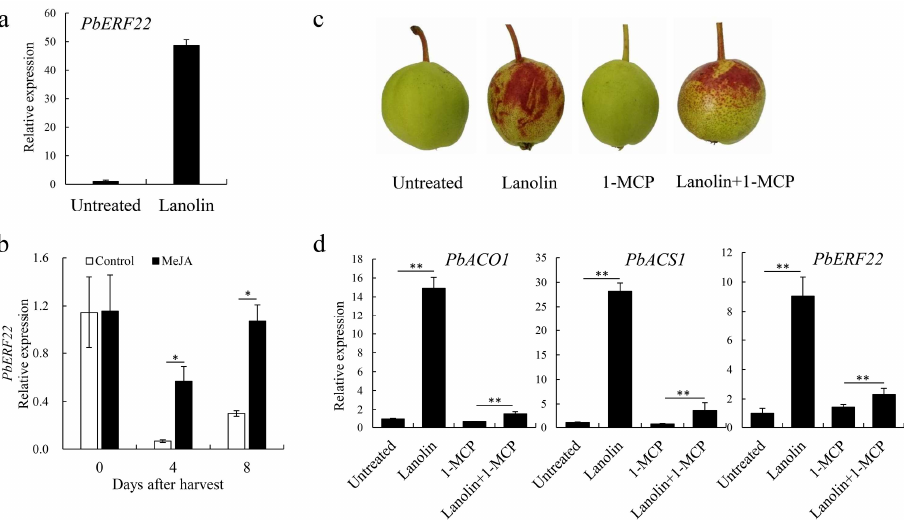
Table 1. Correlation analysis between PbERF22 and anthocyanin biosynthesis-related genes Correlation of factor PbERF22